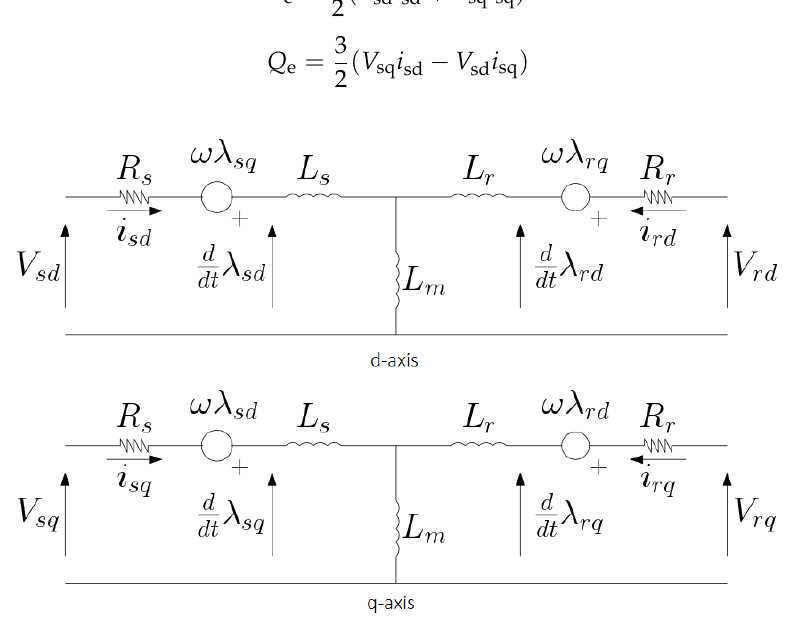
Figure 20. Induction generator dq equivalent circuit, based on